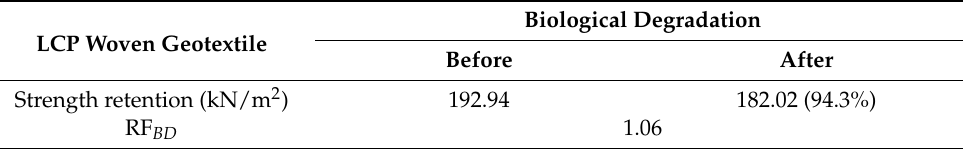
Table 7. Strength retention and reduction factor for biological degradation of LCP woven